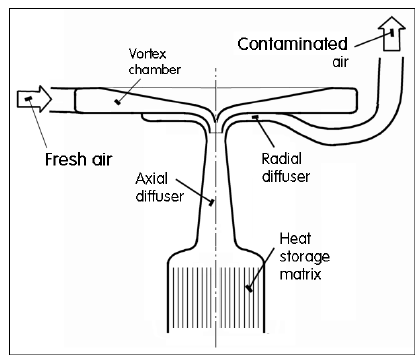
Fig. 24. Detail of the alternator from Fig. 21 with integral vortex valve and the three-terminal flow-directing